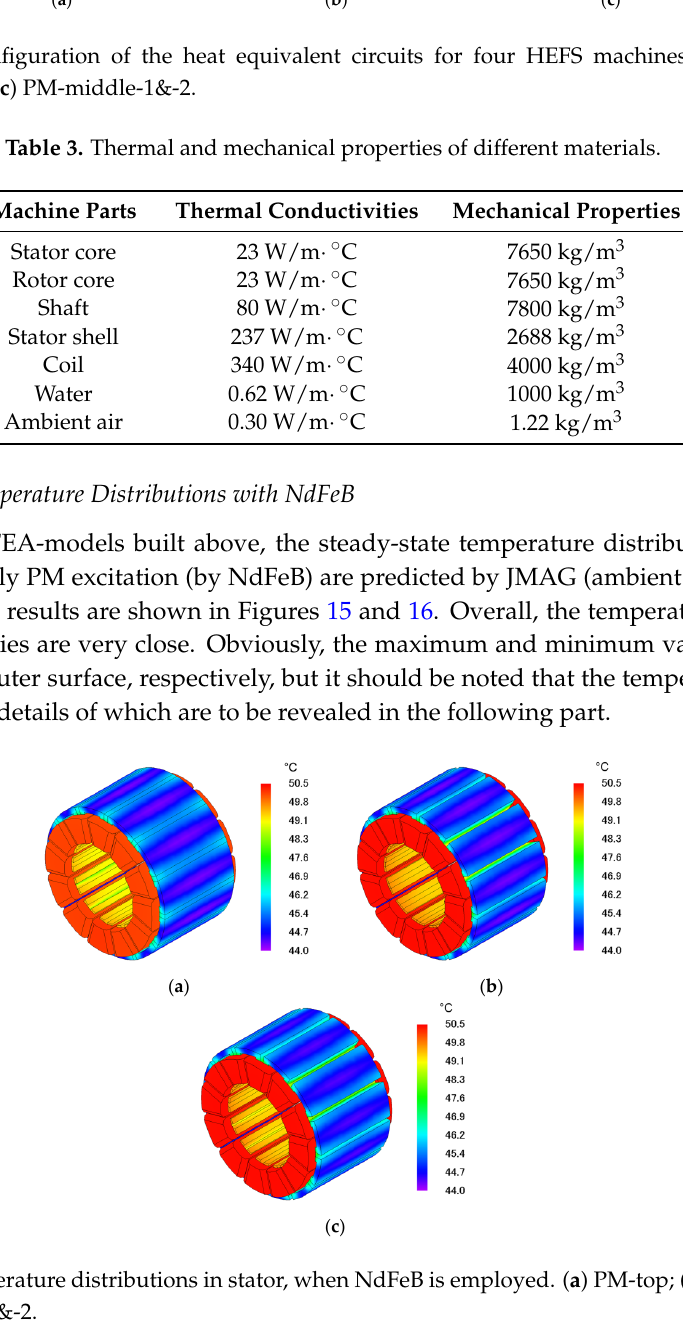
Figure 15. Temperature distributions in stator, when NdFeB is employed. ( a ) PM ‐ top; ( b ) PM ‐ bottom; ( c ) PM ‐ middle ‐ 1& ‐ 2.